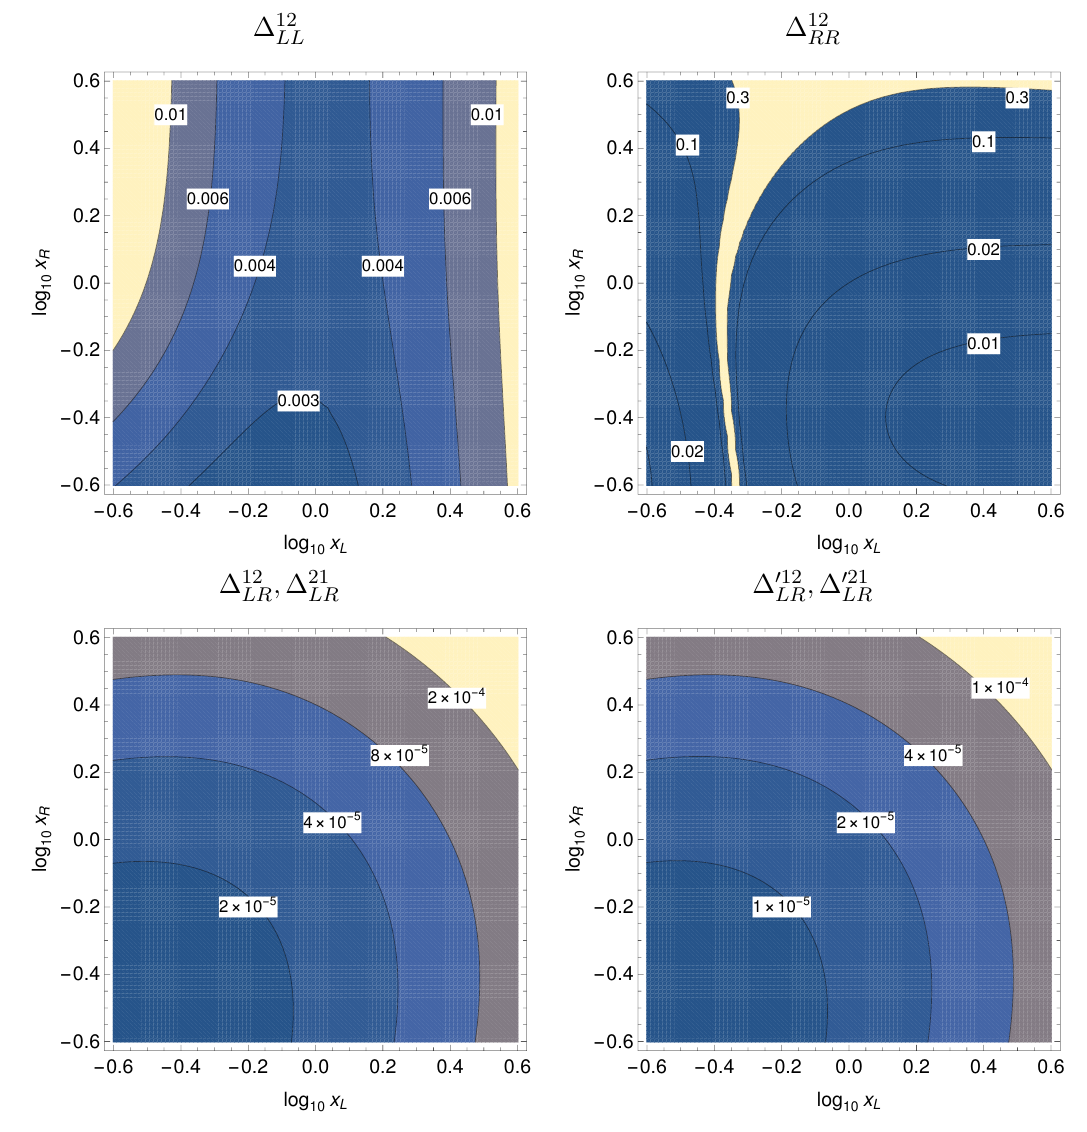
Figure 8 . Upper bounds on the LFV parameters from (cid:22) ! e(cid:13) for tan (cid:12) = 2 and M = 800 GeV as a function of the splitting between the masses of gaugino and sleptons of di(cid:11)erent chiralities. The normalised slepton masses x L ( R ) = m L ( R ) =M are plotted on the